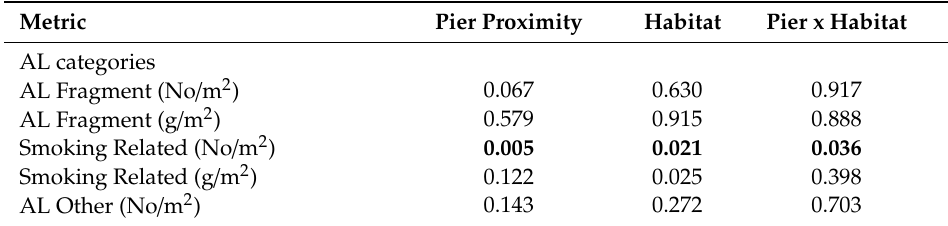
Figure 2. Median (center line) and 25th and 75th percentile (box edges) for ( a ) organic matter density, ( b ) anthropogenic litter (AL) density by number, and ( c ) AL density by mass. Table 2. Anthropogenic litter (AL) and organic matter density were compared according to pier proximity and habitat using the aligned rank tool (ART) approach. The only exception was leaf litter (*) results, which are from two-way ANOVA. Bold indicates p ≤